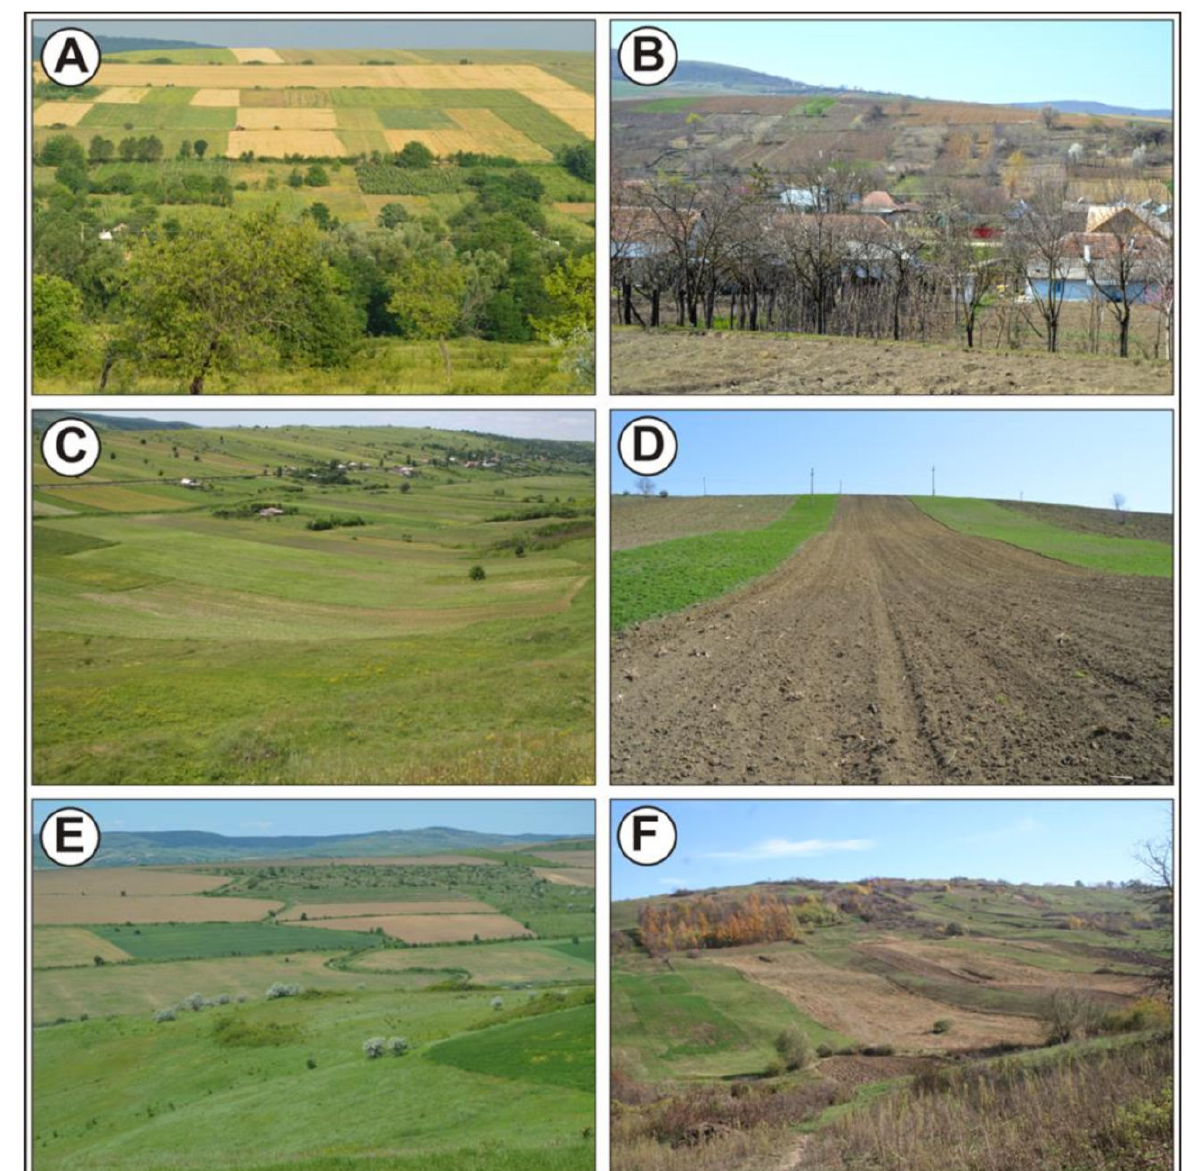
Figure 7. Shifting from contour conservation practices to up-and-down hill farming under small plots: ( A ) in the left side of the Ivanesti valley on 21 June 2017, ( B ) in the left side of the Oprisita valley on 4 April 2016, ( C ) in the middle Toporasti sub-catcment on 8 June 2016, ( D ) in the right side of the Poienesti valley on 4 April 2016, ( E ) in the Cosesti valley with remnants of former conservation practices on the right side (east looking cuesta back-slope) on 29 May 2017, and ( F ) in the left side (west facing cuesta front) of the Racovitza valley on 20 October